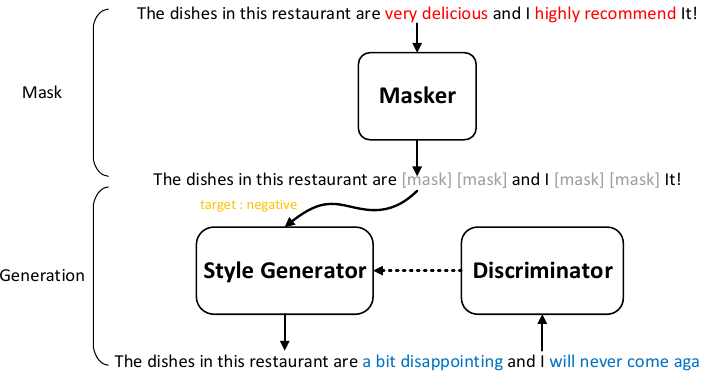
Figure 1. The overview of our approach.